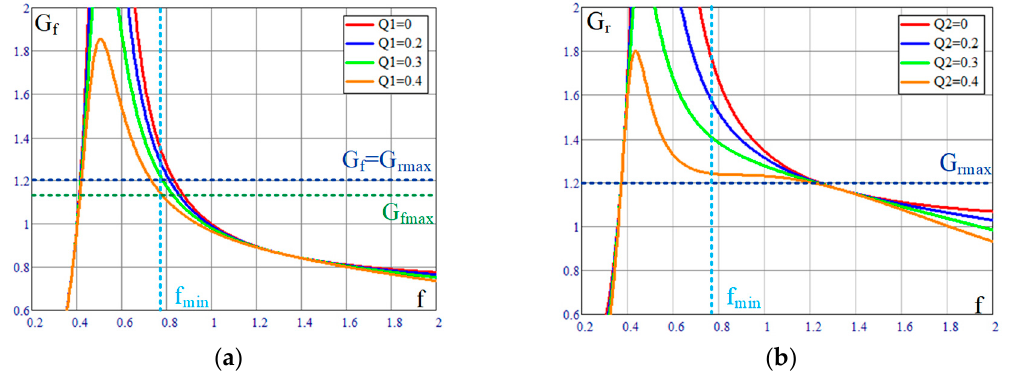
Figure 7. DC gain curves with parameter sweep of Q 1 and Q 2 to illustrate the requirement of G fmax < G rmax . ( a ) Forward mode; ( b ) reverse